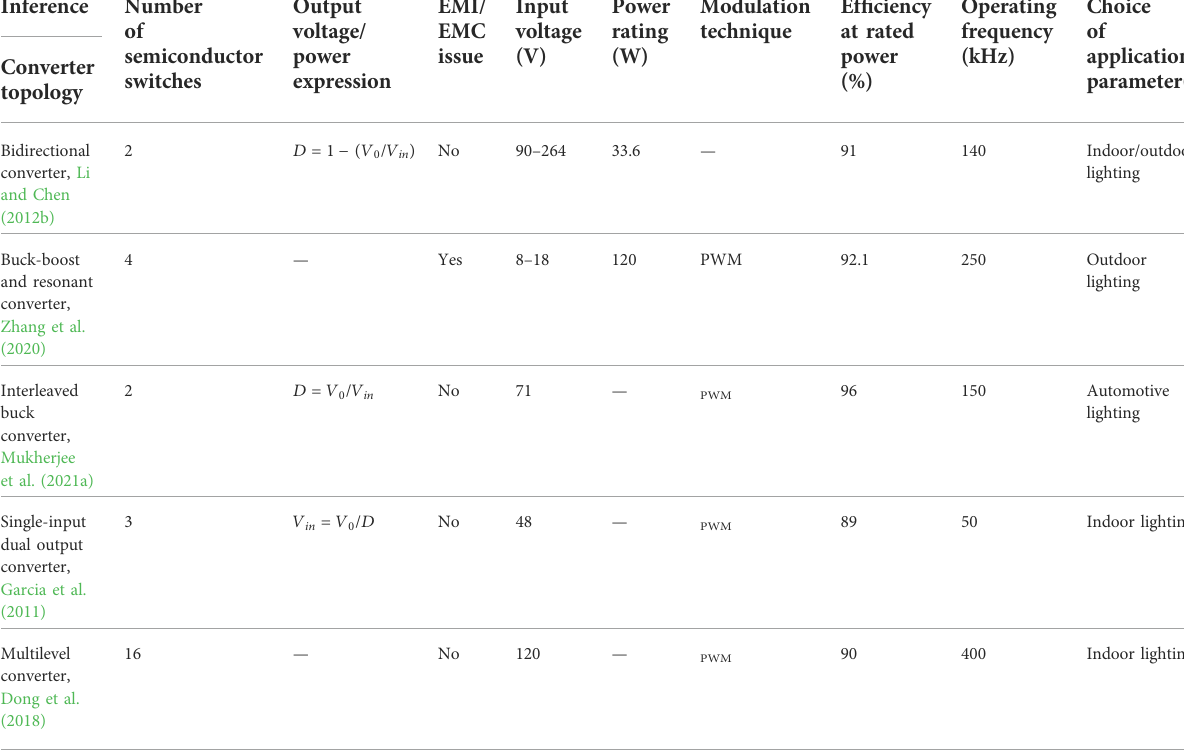
TABLE 2 Summary of various parameters of two-stage converter topologies fed LED non-isolated